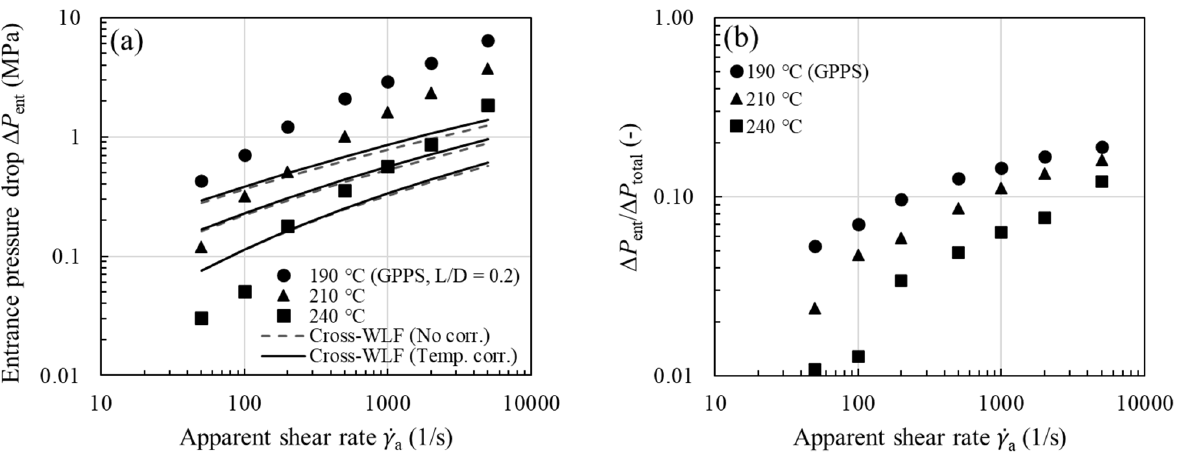
Figure 6. ( a ) Measured entrance pressure drop ∆ P ent (symbols, L / D = 0.2) vs. viscous Cross-WLF model prediction based . γ ) with and without temperature correction (lines) as a function of on η ( drop ∆ P ent for